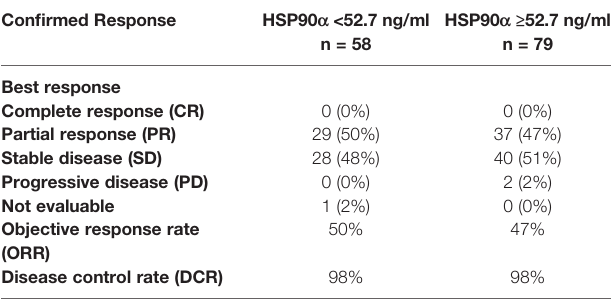
TABLE 6 | Summary of con fi rmed response assessed by RECIST version 1.1. Con fi rmed